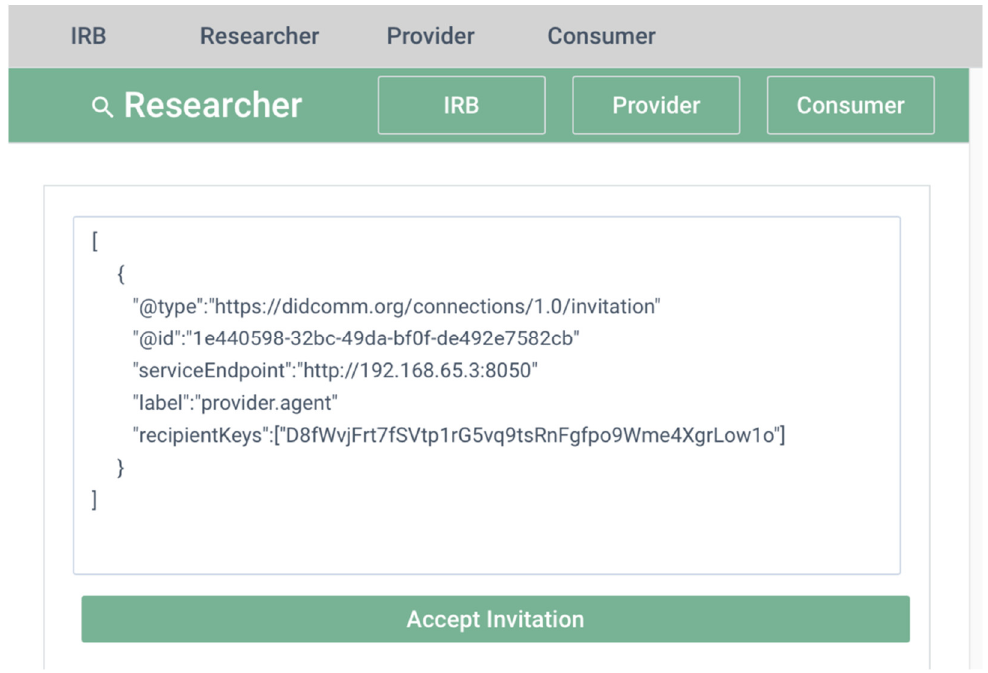
Figure 15. Accepting the invitation message by Researcher.